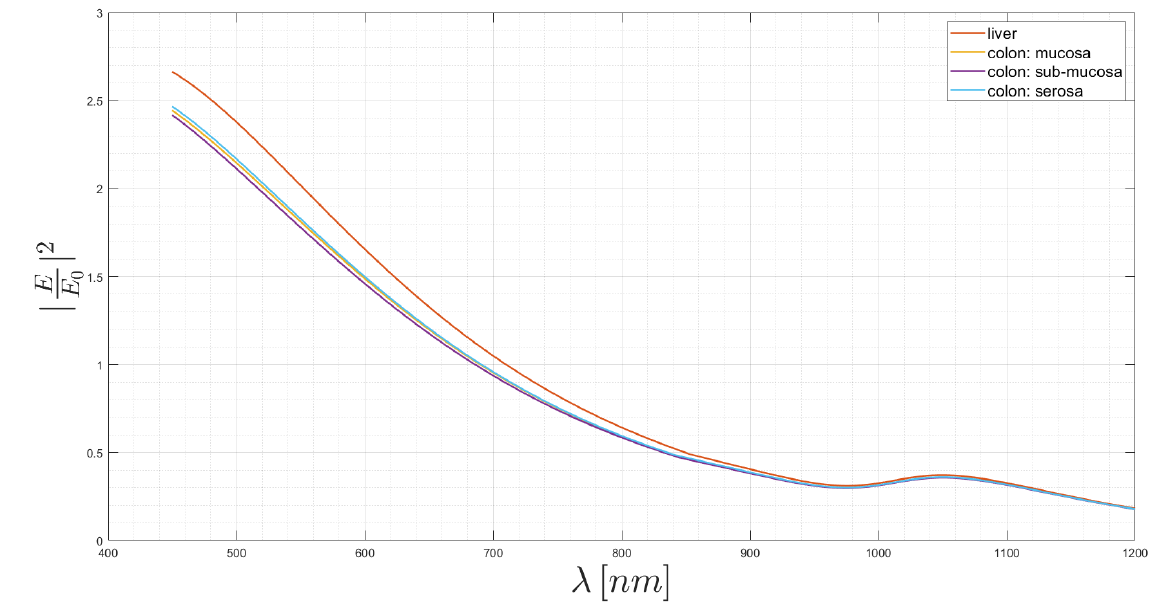
Figure 19. Aluminum nanostructure response for different human body